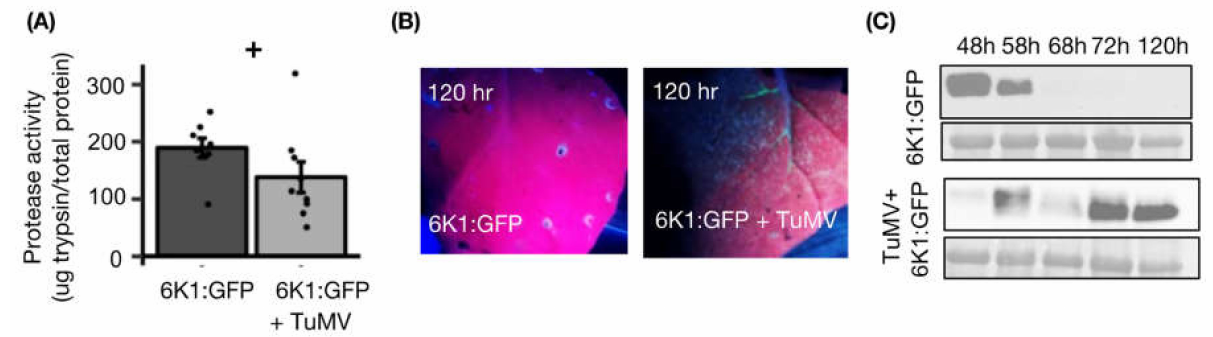
Figure 4. TuMV infection decreases plant protease activity and increases 6K1 stability. N. benthamiana leaves were agro-inoculated with TuMV and 6K1:GFP or just 6K1:GFP. ( A ) Protease activity was quantified and 6K1:GFP quantified with ( B ) UV light at 120 hpi and ( C ) western immunoblots over time. For each sample, an equal volume (10 µ L) was loaded into each well of an SDS-PAGE gel. Anti-GFP antibodies were used in both western blots and Ponceau staining was performed to check for loading control. Each result is mean from ten biological replicates in ( A ). All western blots are representative of at least two replicates which each contained three plants per treatment. A one-way ANOVA was used in ( A ) to check for significance among means ( n = 10, mean ± SE, + indicated a p -value of